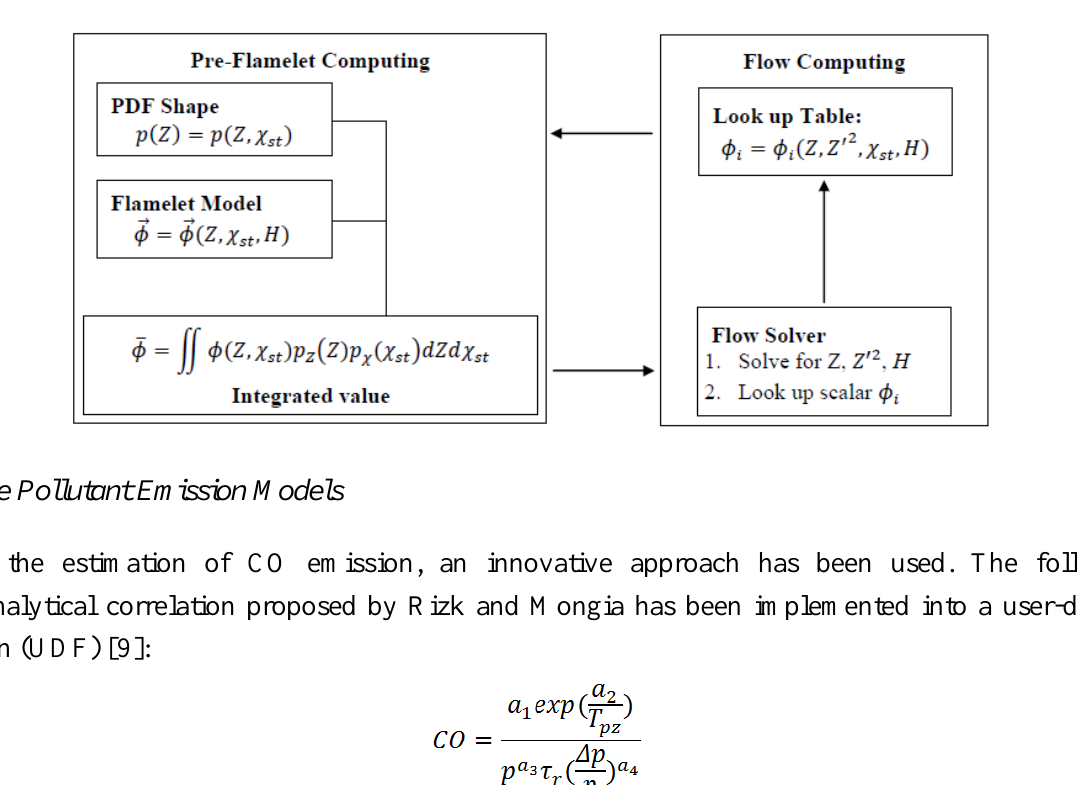
Figure 4. Flamelet model computing. PDF, probability density